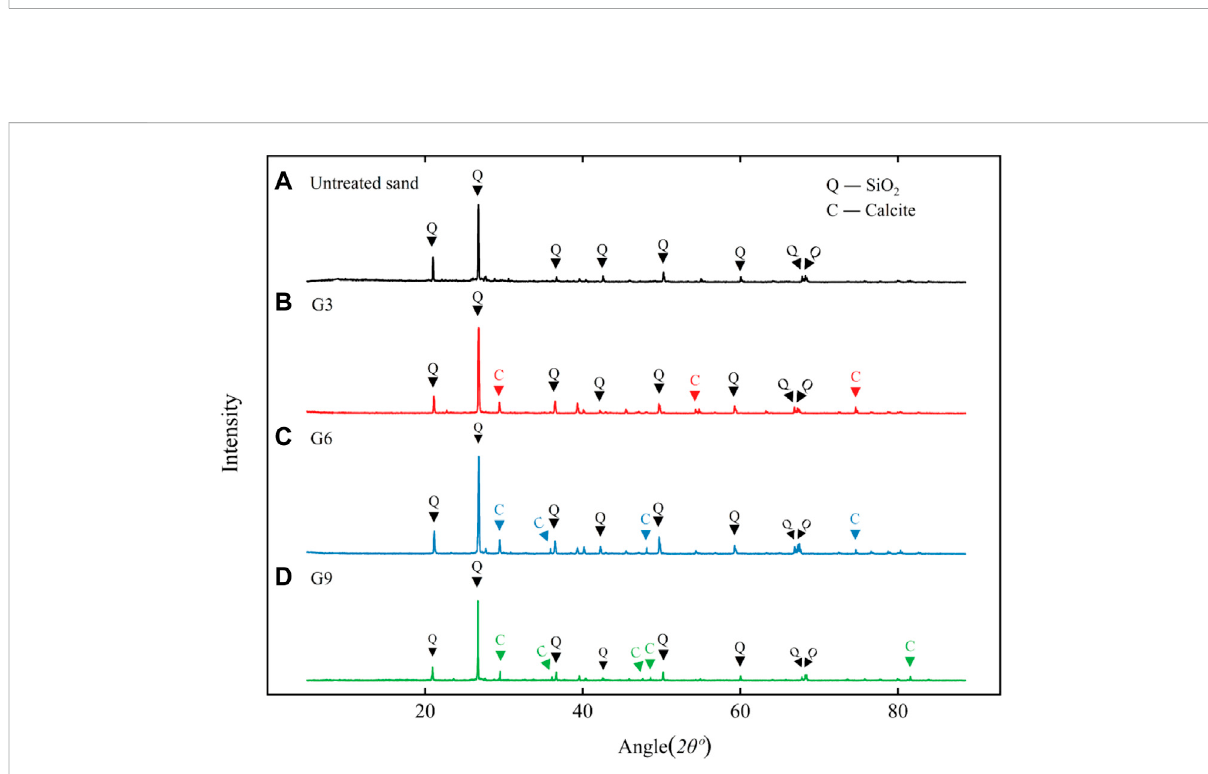
FIGURE 10 XRD analysis results of treated samples: (A) , (B) , (C) , and (D) are the results for untreated sand, G3, G6, and G9, respectively.